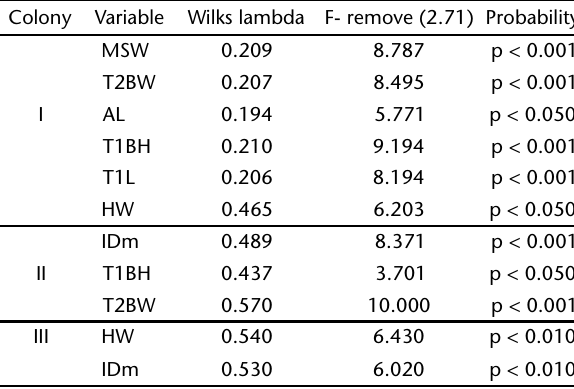
Table I. Morphometric discriminatory variables (mm) between females of the studied colonies of P. compressa according to Discriminant Function